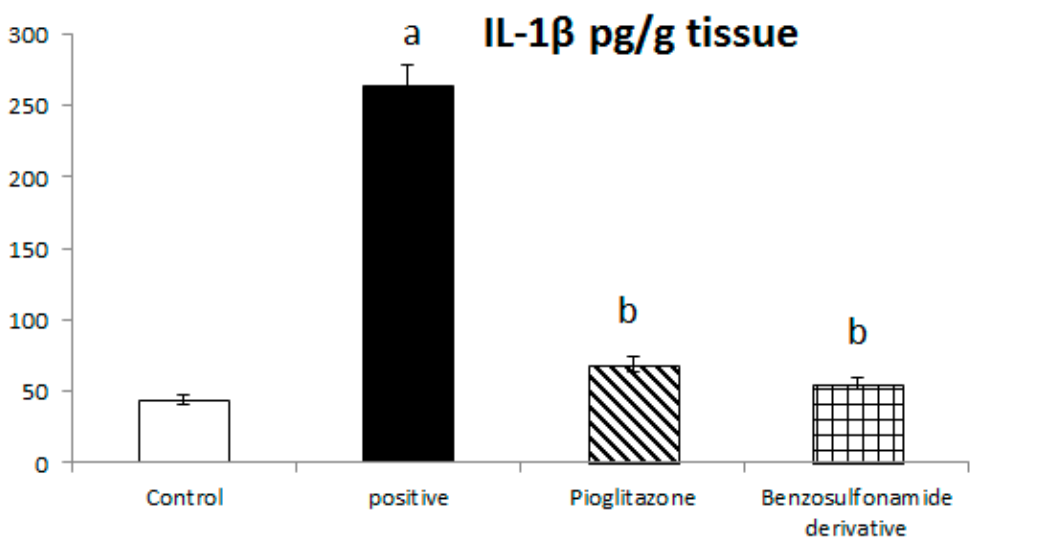
Figure 4. Bar chart presentation of liver tissue IL-1 β concerning the effect of 14 days of oral admin- istration of the synthetic compound against the reference anti-hyperglycemic pioglitazone on STZ- induced type 2 DM. DM: diabetes mellitus. Each bar represents the mean of 6–8 values ± the stand- ard error of the mean (S.E.M). a: Significantly different from the normal control group, b: Signifi- cantly different from the positive control group.